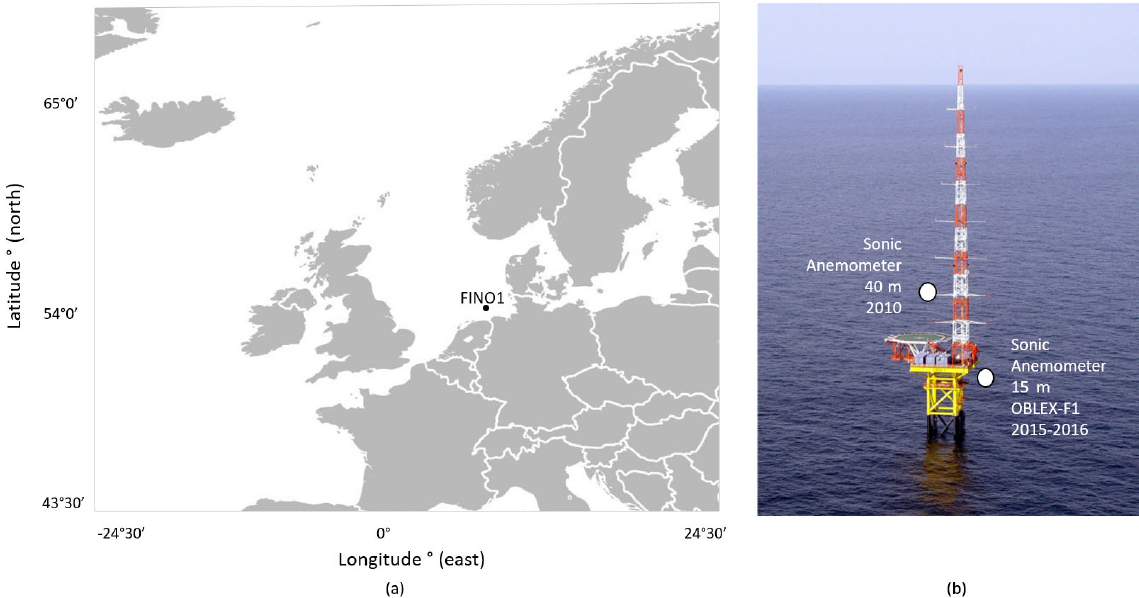
Figure 2. (a) Location of the FINO1 measurement mast in the North Sea. (b) View of the FINO1 measurement mast and the location of the two sonic anemometers used to obtain the new roughness length parameterization (modified from Muñoz-Esparza et al.,